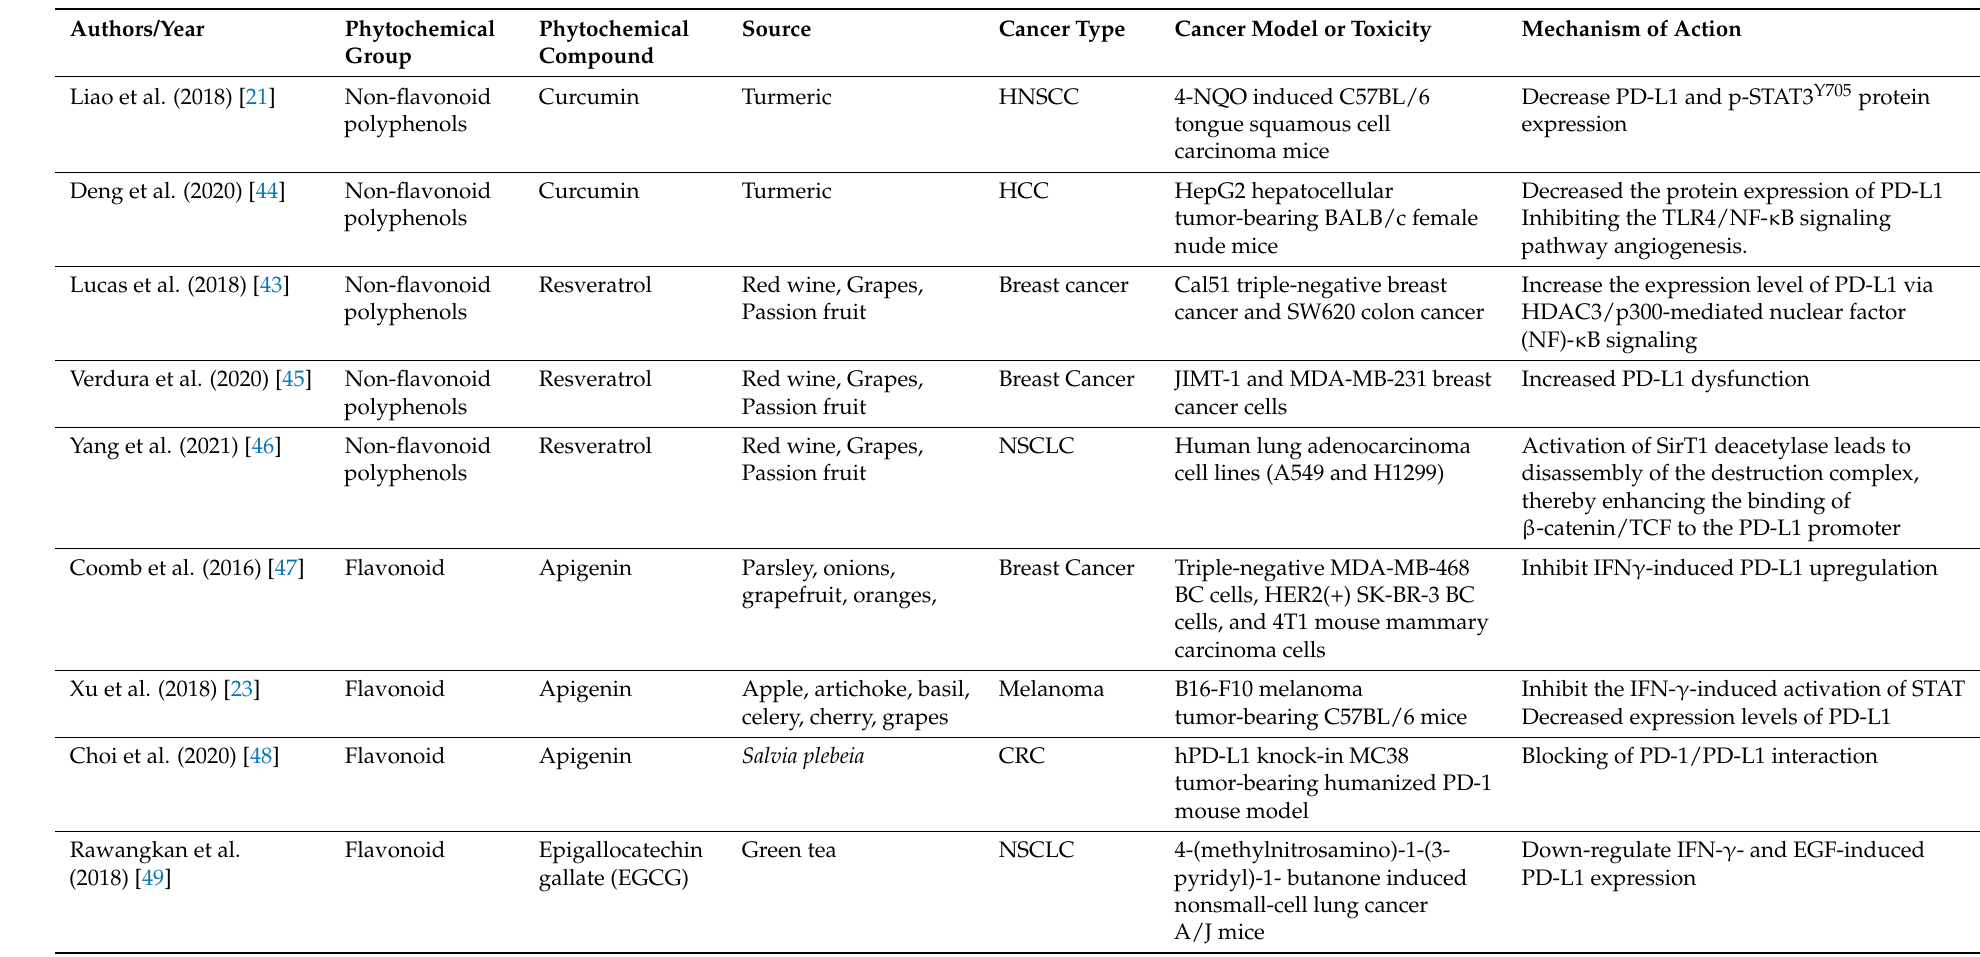
Table 2. Summary of phytochemicals targeting PD-L1/PD-1 and CTLA-4 pathways in different types of